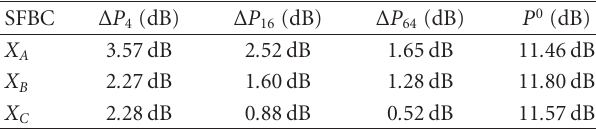
Table 2: PAPR Reduction results for Di ff erent Space-Frequency Block Codes and Modulation